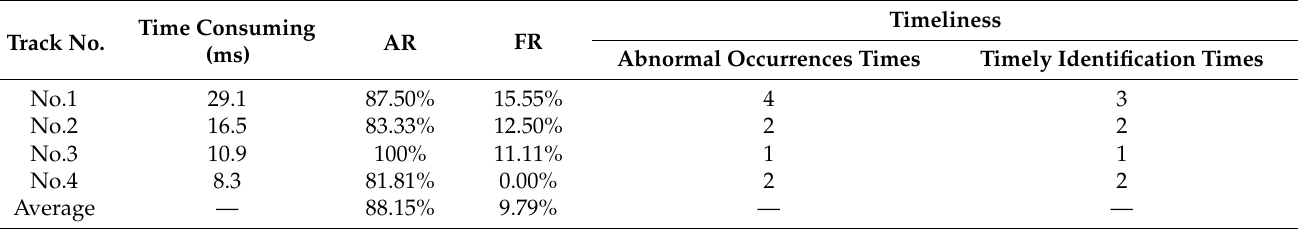
— — Table 14. Evaluation of ship trajectory anomaly detection results based on